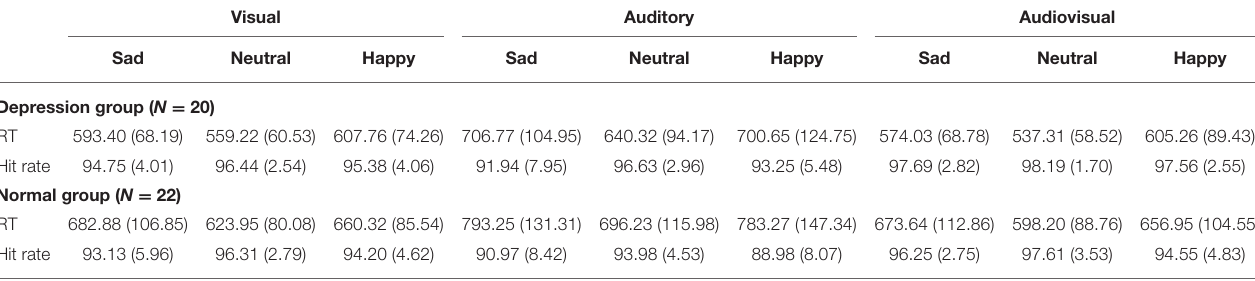
TABLE 2 | Mean response times (ms) and hit rates (%) in both the depression and normal groups in response to different emotions. Visual Auditory Audiovisual Sad Neutral Happy Sad Neutral Happy Sad Neutral